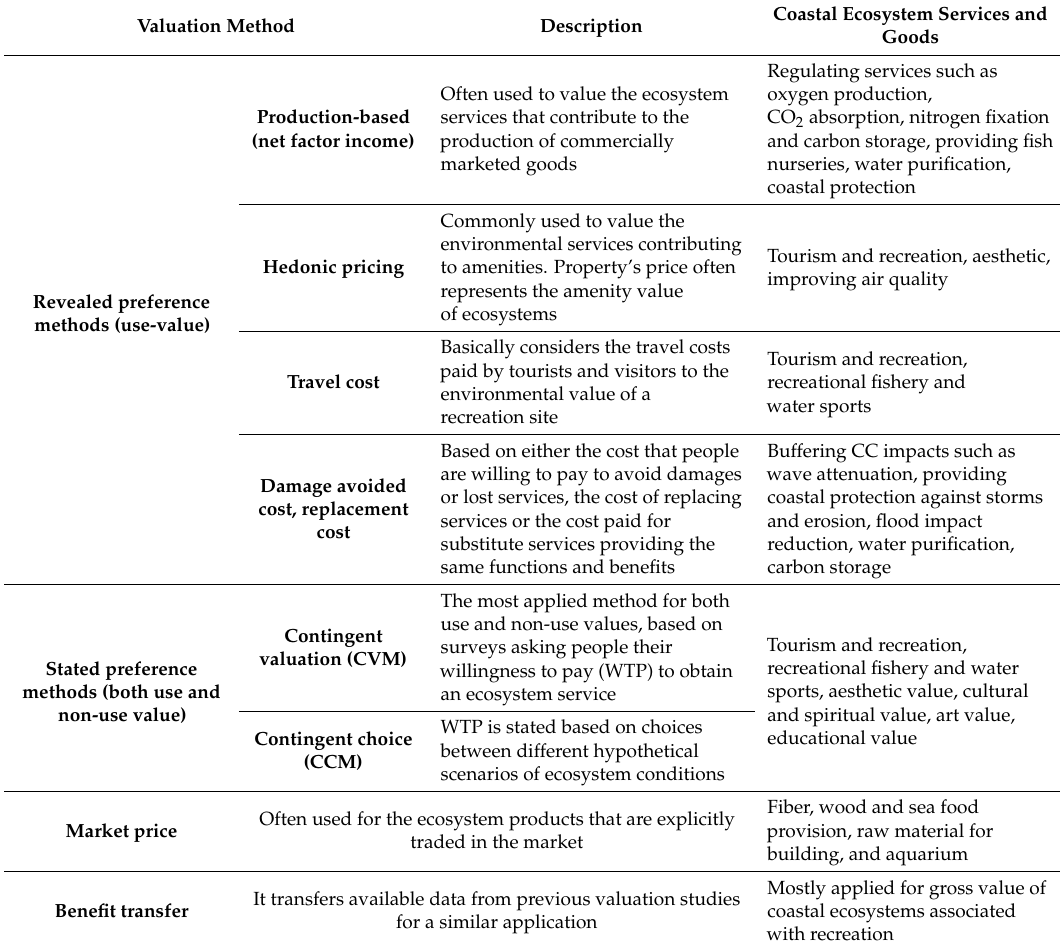
Table 3. Overview of the valuation methods and their attributed coastal ecosystem services and